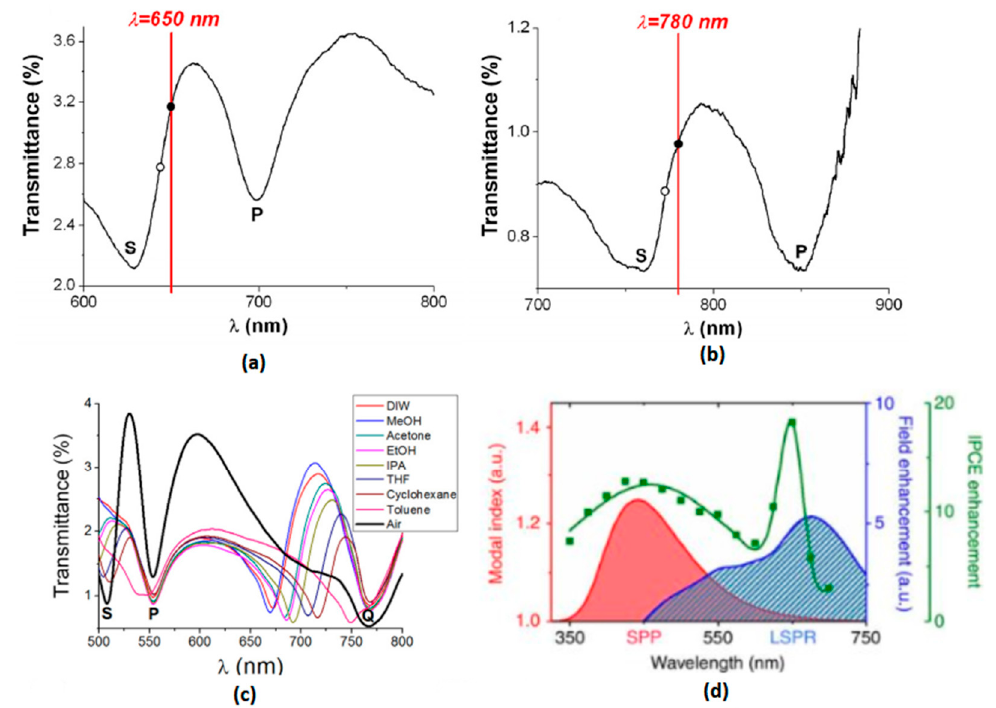
Figure 2. ( a , b ) Experimental transmission spectra of 620-nm-period and 750-nm-period aluminum nanohole array indicating their S mode (at the air/metal interface) and P mode (at the glass/metal interface) SPP resonance wavelength, ( c ) Transmission spectra of 500-nm-period aluminum nanohole arrays in different dielectric medium indicating their S mode (at the medium/metal interface) and P, Q mode (at the glass/metal interface) SPP resonance wavelength, [4] (Reprinted from Biosensors under CC-BY license), ( d ) Incident photon to current conversion efficiency (IPCE) enhancement and field enhancement of SPP and LSPR mode from 500-nm-period Au nanohole arrays in hematite photoanodes. Reproduced with permission from [17]. Copyright Springer Nature, 2013.